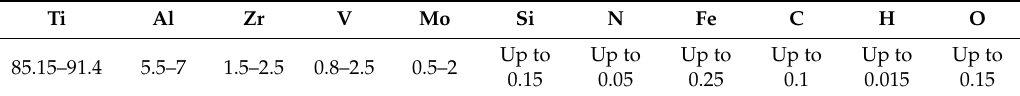
Table 1. Chemical composition (%) of the titanium alloy to be